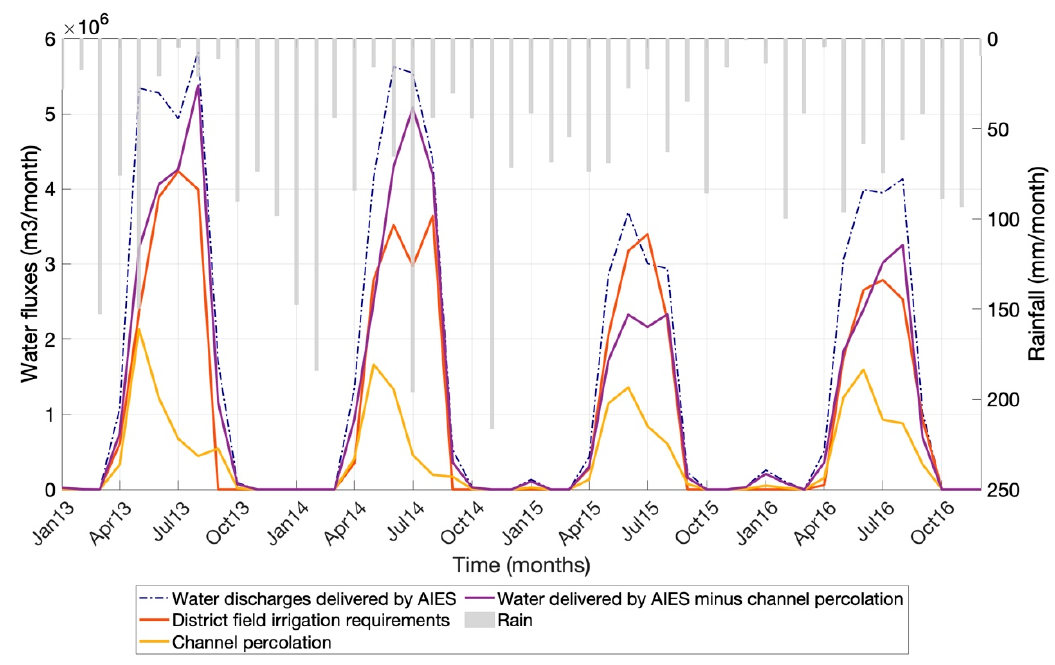
Figure 8. Monthly measured and simulated water fluxes for the ‘current state’ condition (2013–2016) in the W-San Giorgio di Lomellina irrigation